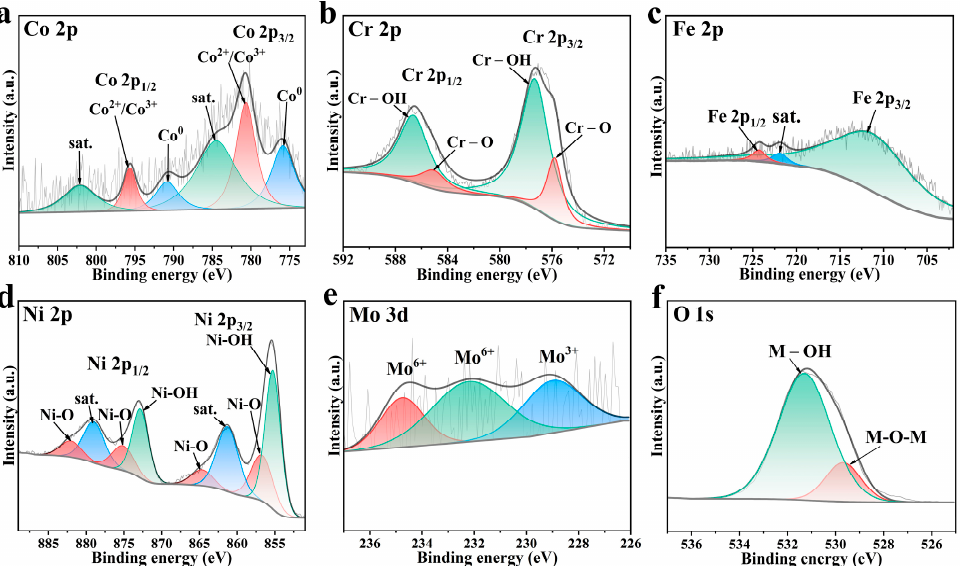
Figure 4. Surface chemical states of LDHs-3 M-12 h and high-resolution XPS of ( a ) Co 2p. ( b ) Cr 2p. ( c ) Fe 2p. ( d ) Ni 2p. ( e ) Mo 3d. ( f ) O 1s.